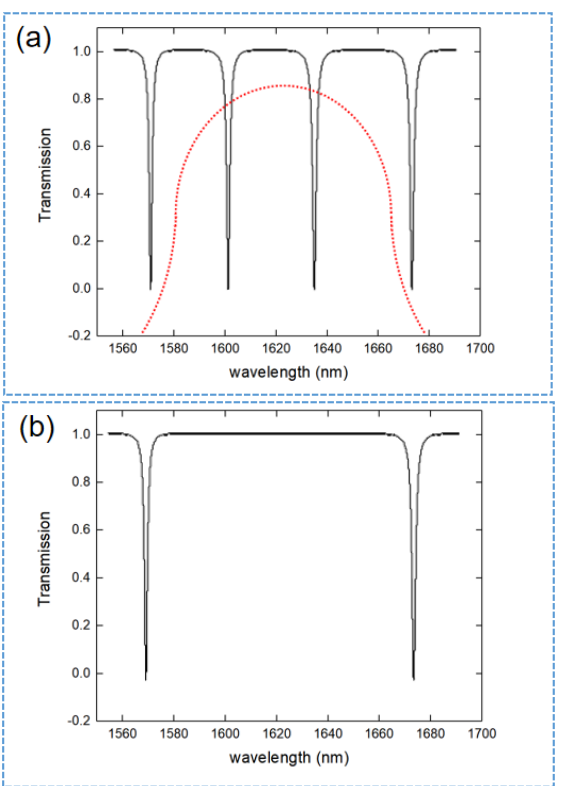
Figure 3. ( a ) The spectral responses of the grating − free microring. ( b ) The spectral response of the ASGMRR.